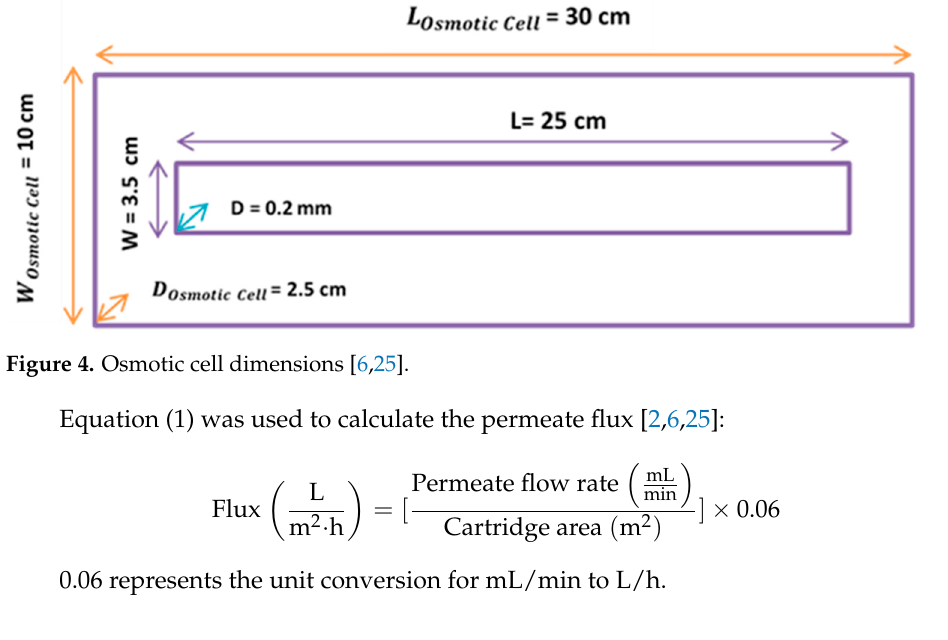
Figure 3. ( a ) PRO membrane setup at Hydro-Quebec Research Institute, ( b ) schematic of PRO membrane setup [6,12,25].